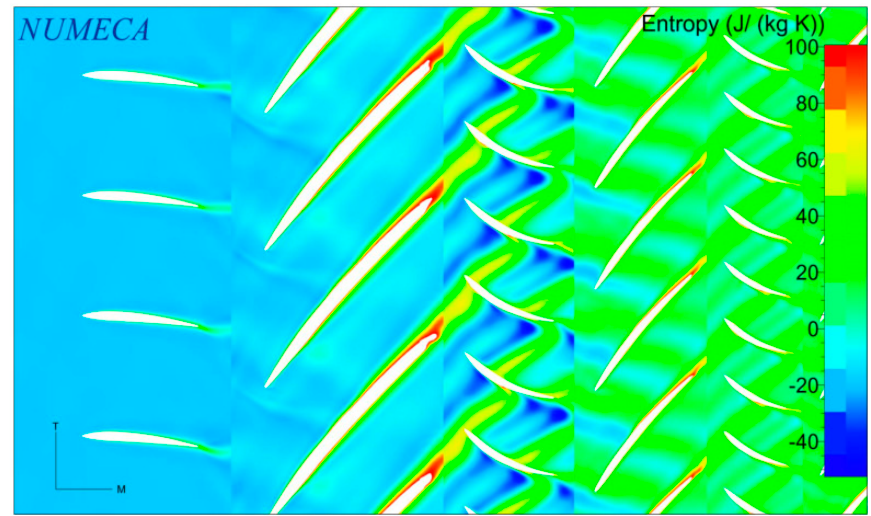
Figure 19. Entropy at a single point in time from an unsteady solution at 50% span